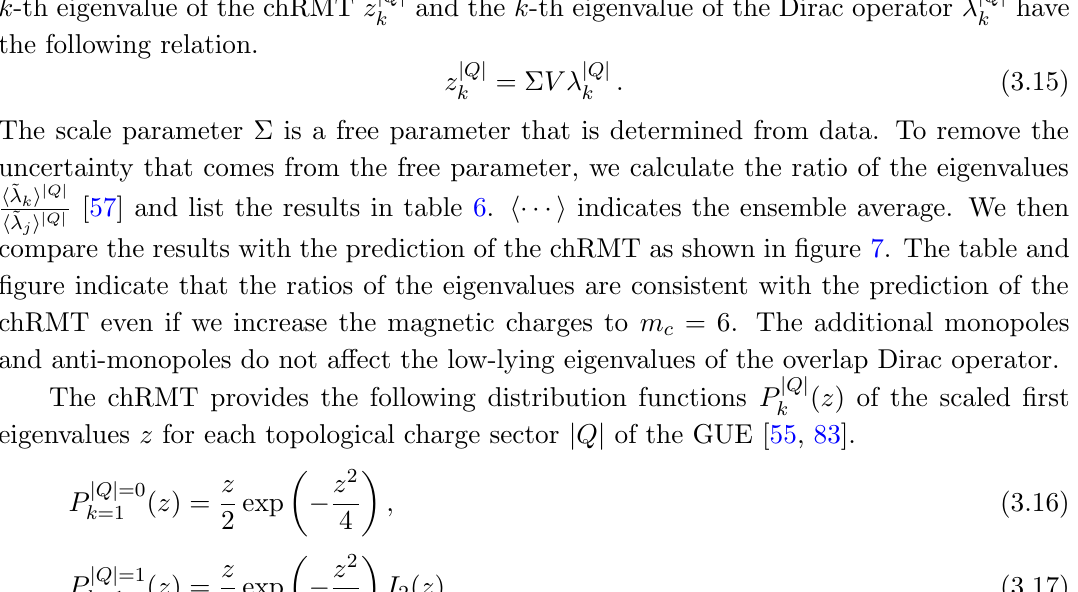
Table 6 . The numerical results of h the con(cid:12)gurations of the magnetic charges m c from 0 to 6 are used. The results of the comparison with RMT are presented in table 3